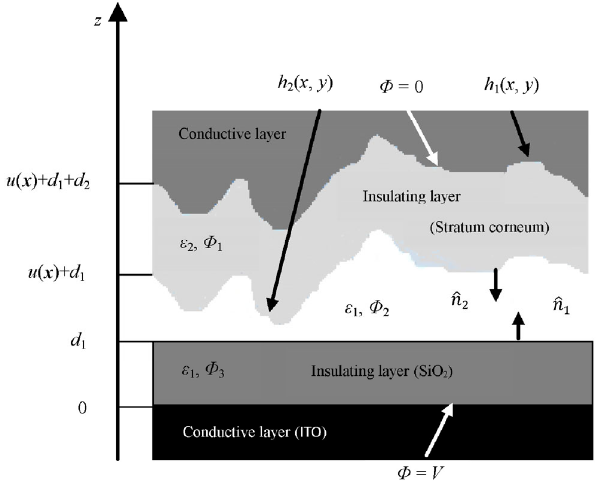
Fig. 1 A schematic of a finger above a flat